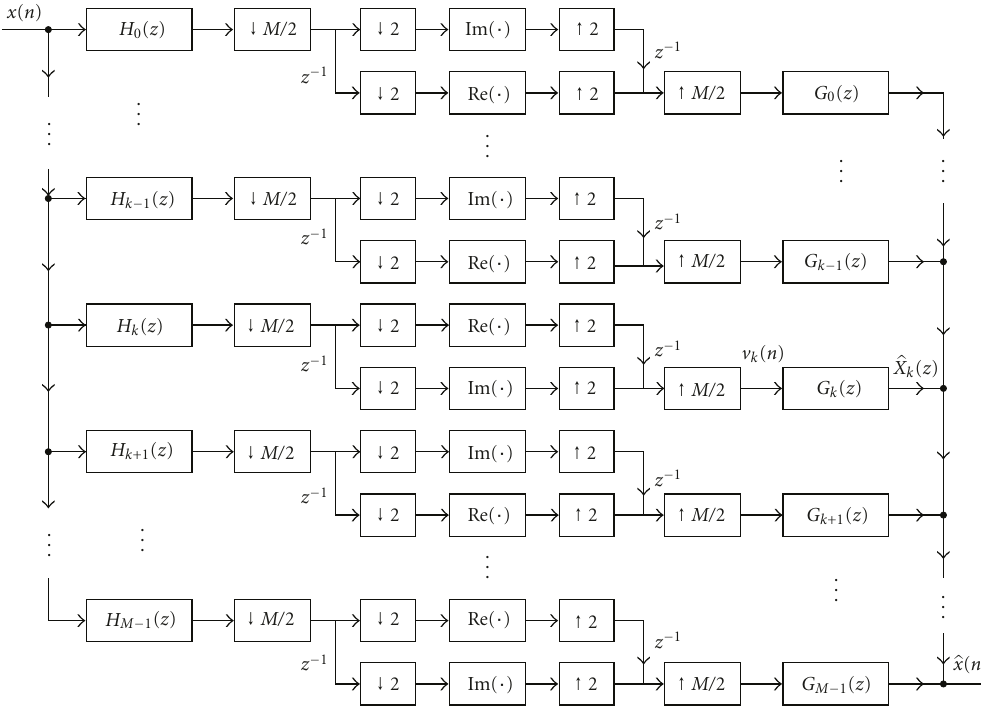
Figure 1: M -channel MDFT filter bank, where M is